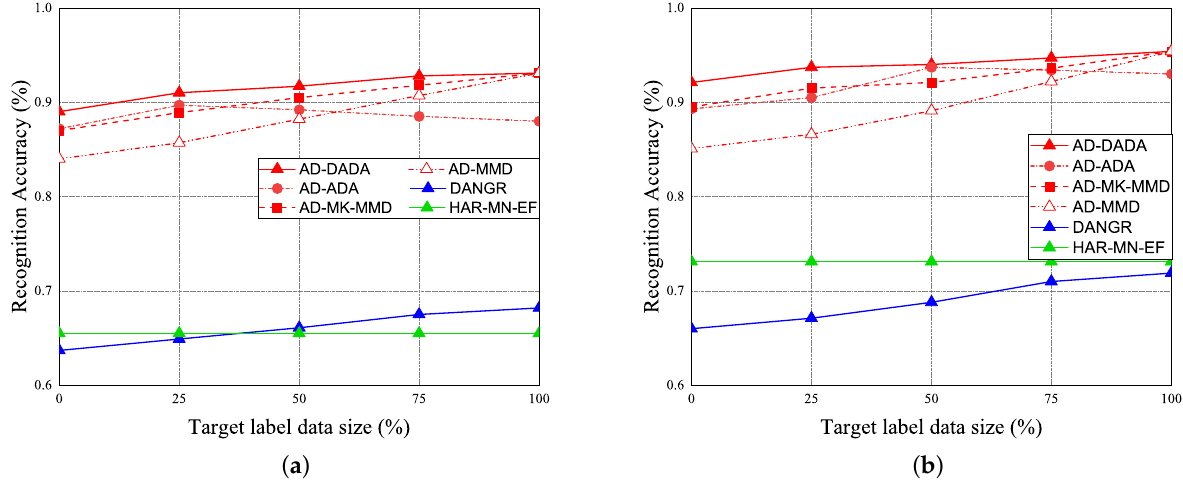
Figure 23. RA vs. various ratios of labeled data for ( a ) target (A) and ( b ) target (B) under target data ratio = (1:1:1:1:0.1).